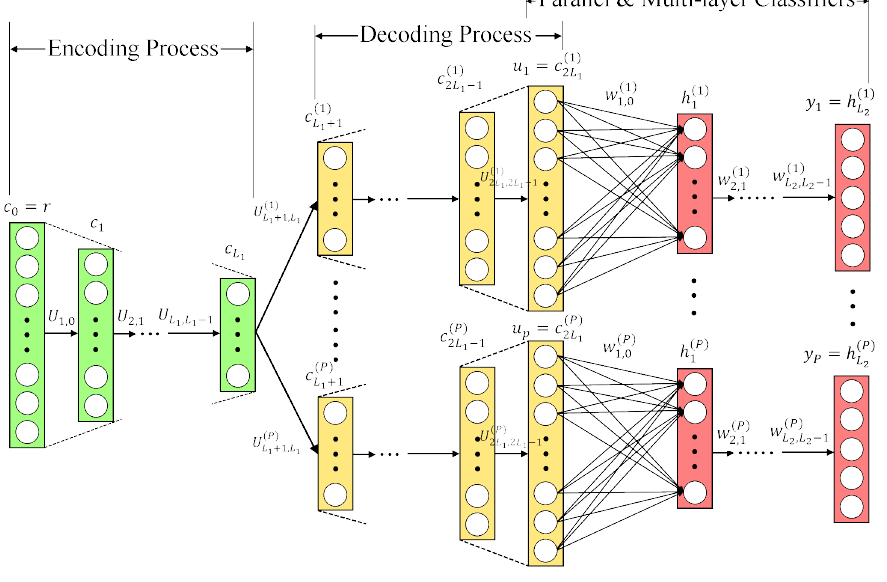
Figure 2. Deep neural network autoencoder structure [9] for DOA